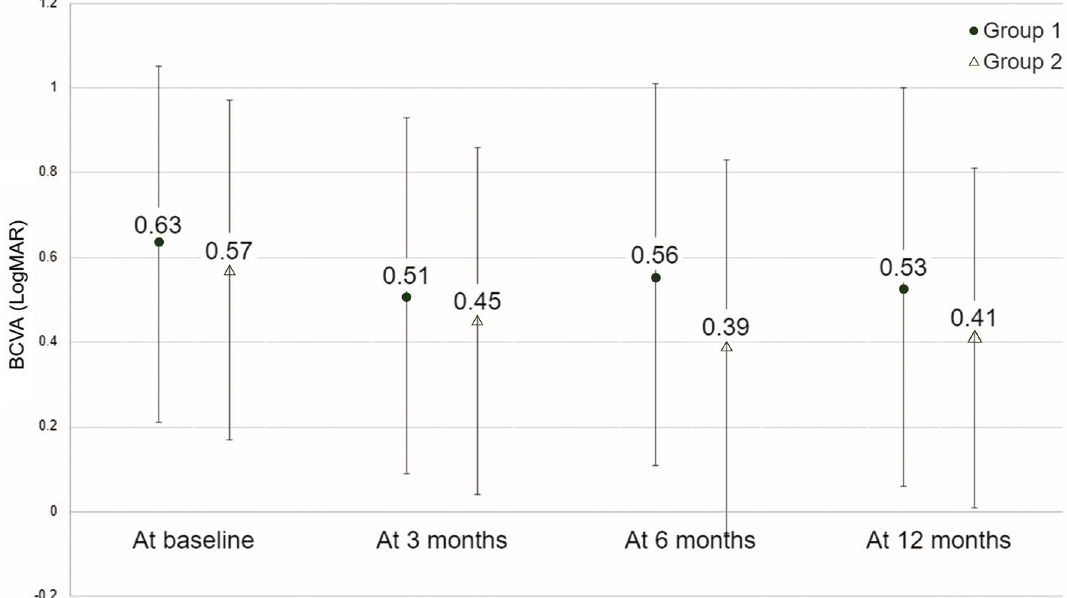
Figure 1. Mean visual acuity in the two treatment groups at different timepoints. Group 1 intravitreal injection of ranibizumab + photodynamic therapy, Group 2 intravitreal injection of aflibercept alone, BCVA best-corrected visual acuity, LogMAR logarithm of the minimum angle of